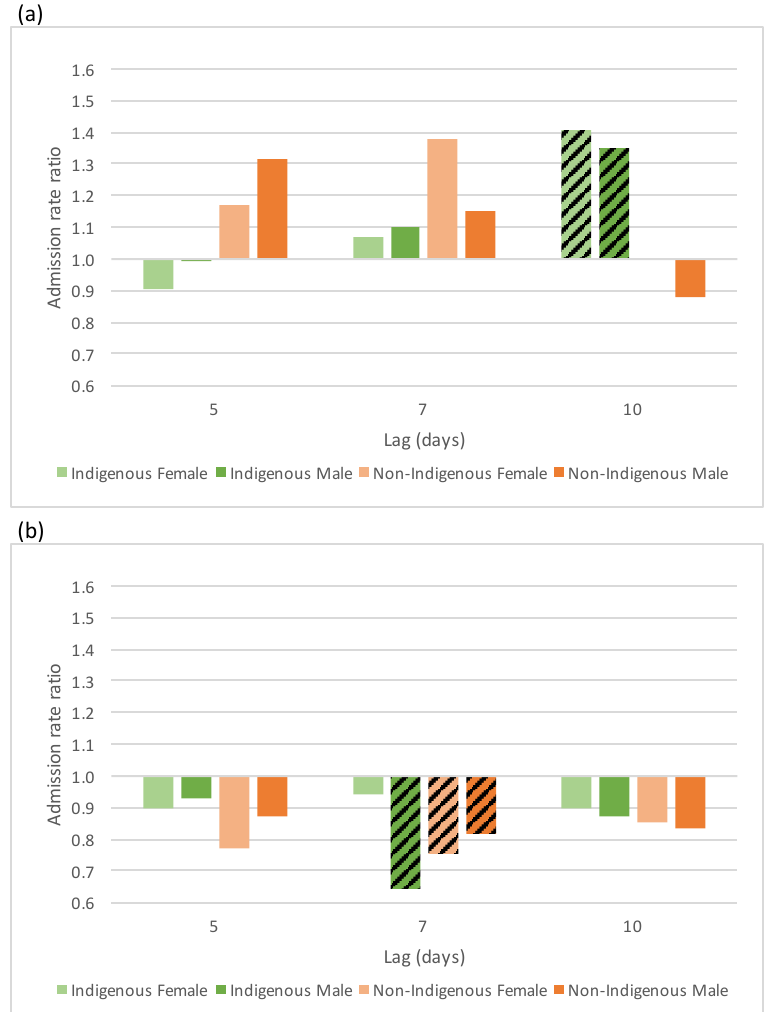
Figure 5. Selected hot effects on acute respiratory admissions, expressed as rate ratios, by Indigenous status and sex over lags of 5 to 10 days. ( a ) Hot effects defined by Tmin, on residents aged 0–9 in the Central Australia climate zone; ( b ) hot effects, defined by Tmax, on residents aged 35+ in the Top End climate zone. Effects that are statistically significant at the five per cent significance level are highlighted with a diagonal